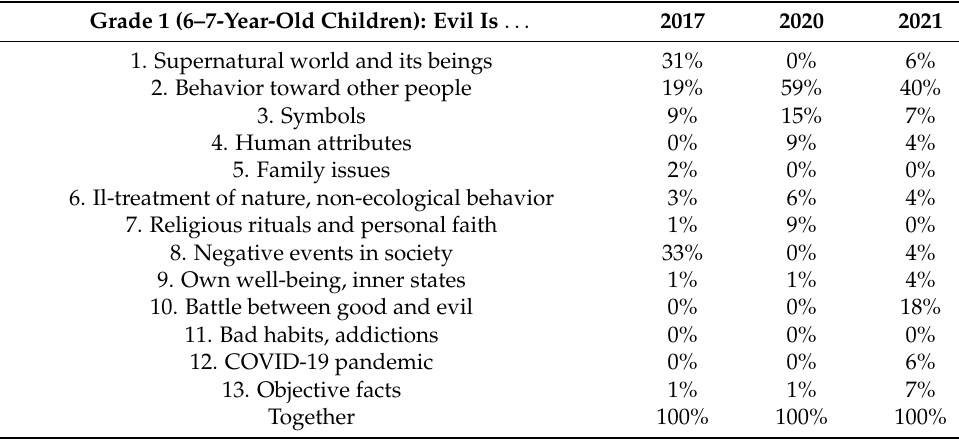
Table 5. The concept of evil by 6–7-year-old children (Grade 1). Grade 1 (6–7-Year-Old Children): Evil Is . . .